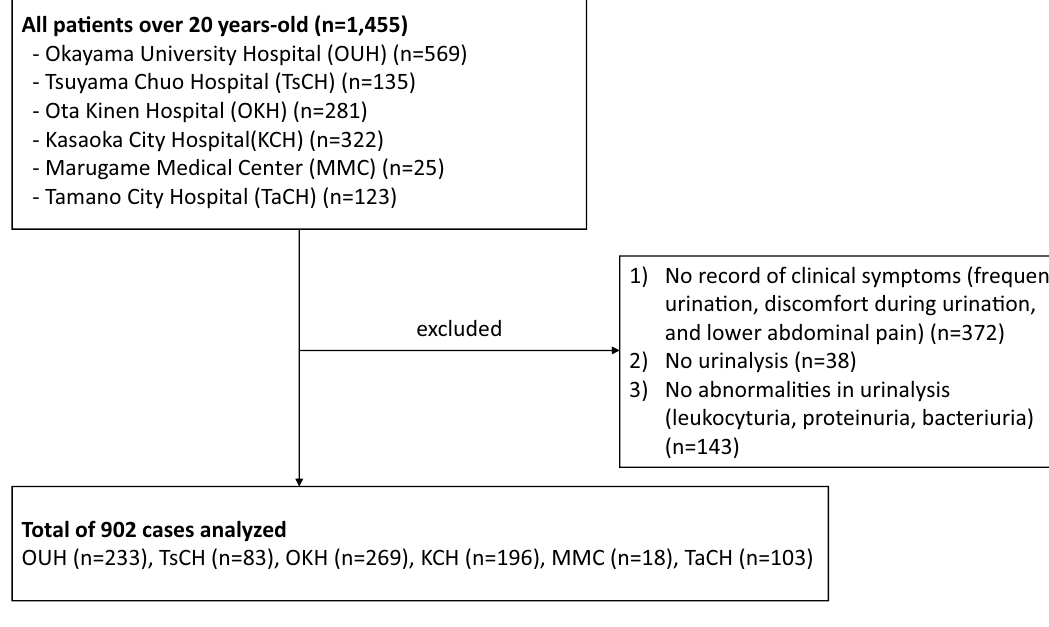
Figure 1. Overall study